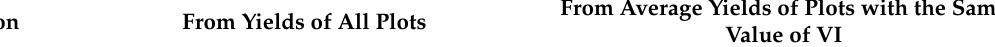
Table 5. Comparison of correlation coefficients (R), coefficients of determination (R 2 ) and Root Mean Square Error (RMSE) of NDVI, BNDVI, and NDYI vegetation indices and yields in different methods of